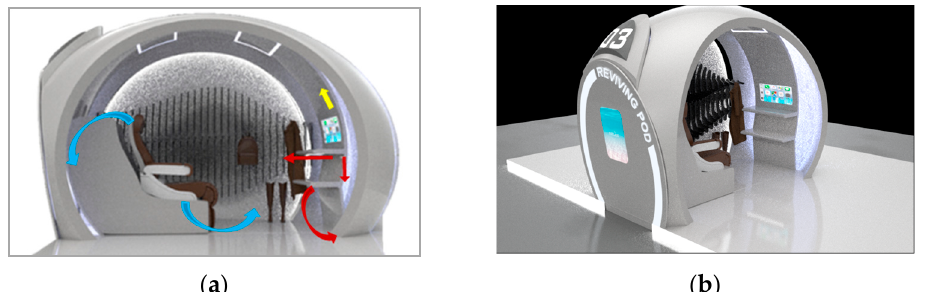
Figure 6. ( a ) Perspective view designed by the authors illustrating the adaptable transformable ad- justable interior units for different multi-functional uses (the interior design elements); ( b ) perspective view illustrating the pod’s interior and exterior design, emphasizing the wayfinding elements, pod number, LED lights, and external smart digital touch screen (the exterior design elements). Arrows’ illustration showing different furniture adaptability.